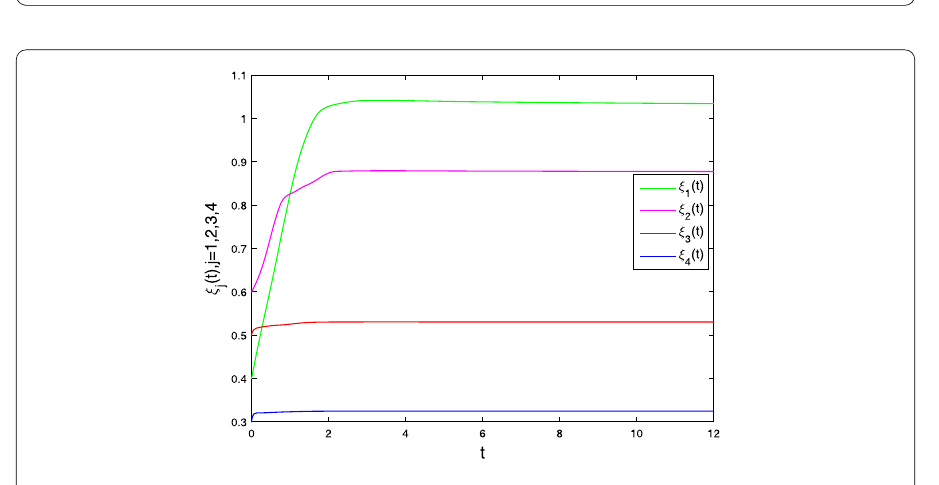
Figure 7 Time response curves of ξ j ( t ), j =